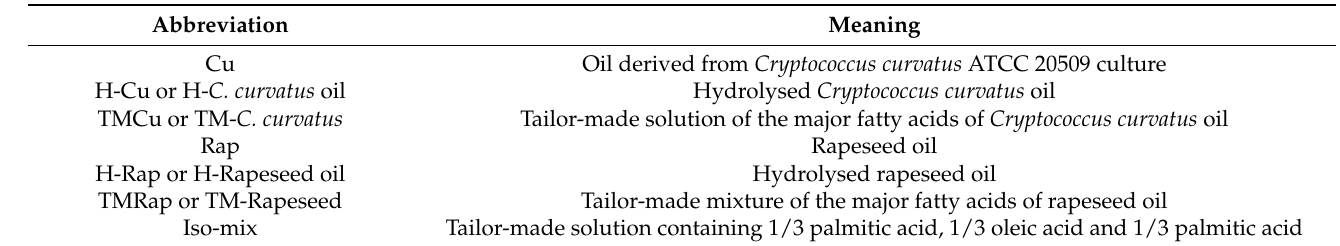
Table 11. Abbreviation and meaning for fatty acids mixtures and